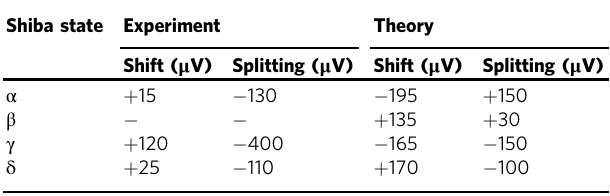
The energetic shifts were calculated from the experimental and theoretical results by (cid:5) (cid:5) (cid:5) (cid:5) (cid:5) (cid:5) (cid:5) (cid:5) (cid:5)(cid:6) (cid:7) (cid:5) (cid:5) (cid:5) (cid:5) (cid:3) E n (cid:5) (cid:5) þ E n (cid:5) 1 , where E n are the energetic positions of the single-adatom Shiba states 2 E n 2 1 n 2 ð α ; β ; γ ; δ Þ , and E n and E n are the energies of the respective hybridized Shiba states in the 2 1 dimer. The splittings of hybridized Shiba states are calculated by E n